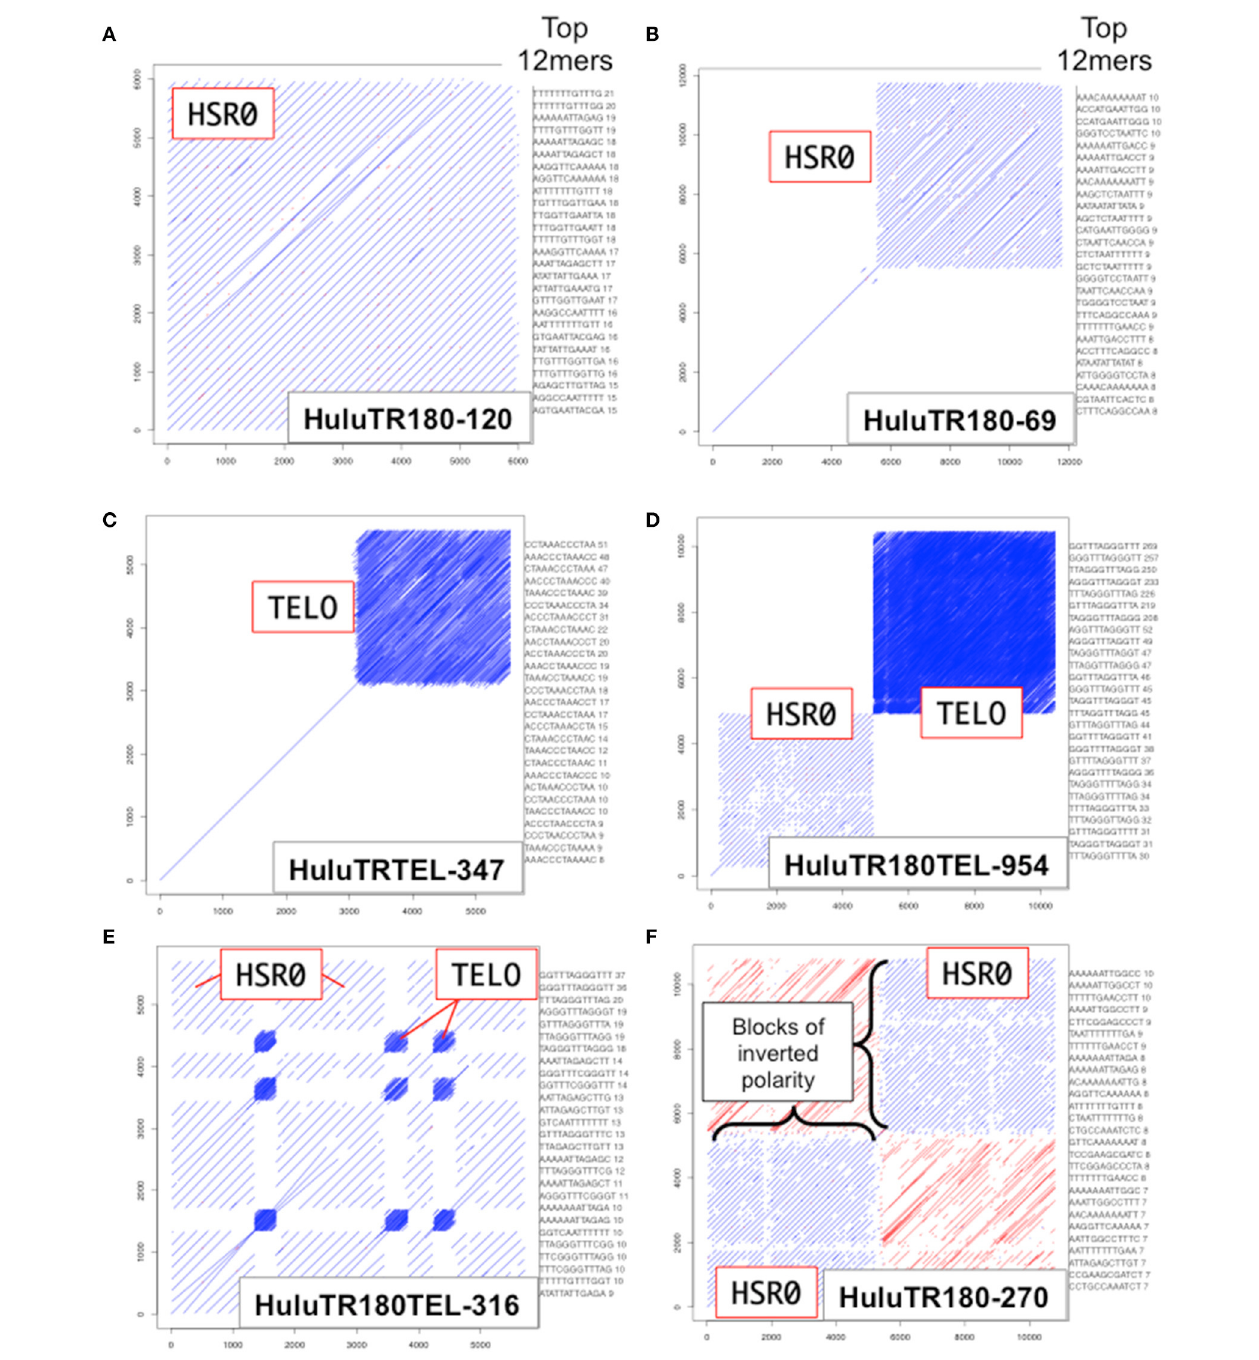
FIGURE 2 | HSR0 dot plot outputs of tandemly repetitive genomic regions. PacBio Single Molecule, Real-Time (SMRT) DNA sequences were screened for tandem repeats (Ohtsubo et al., 2008). For each clone, a self dot-plot is shown along with the top 20 12mers for that clone using kmer analysis. The stripes represent internal tandem repeats of HSR0 (blue stripes) or telomere repeats (tightly packed blue stripe blocks). (A) The HuluTR180-120 clone showing HSR0 repeat occupies the entire 6 Kbp clone. (B) The HuluTR180-69 clone showing HSR0 repeat occupies around one half of the 6 Kbp clone, whereas the single diagonal represents sequences that are not repeated within the clone. (C) The HuluTRTEL-347 clone showing with unique sequences in the first 3 kbp followed by telomere repeat DNA (CCCTAAA n ) in the last ∼ 3 kbp. (D) The HuluTR180TEL-954 clone showing a large block of HSR0 repeats immediately followed by more than 5 Kbp of telomere repeat DNA (TTTAGGG n ). (E) The HuluTR180TEL-316 clone showing interspersed blocks of HSR0 and telomere repeat DNA (TTTAGGG n ). (F) The HuluTR180–270 clone showing a block of HSR0 repeats in one direction (blue) followed by blocks of inverted repeat polarity (red) in another.